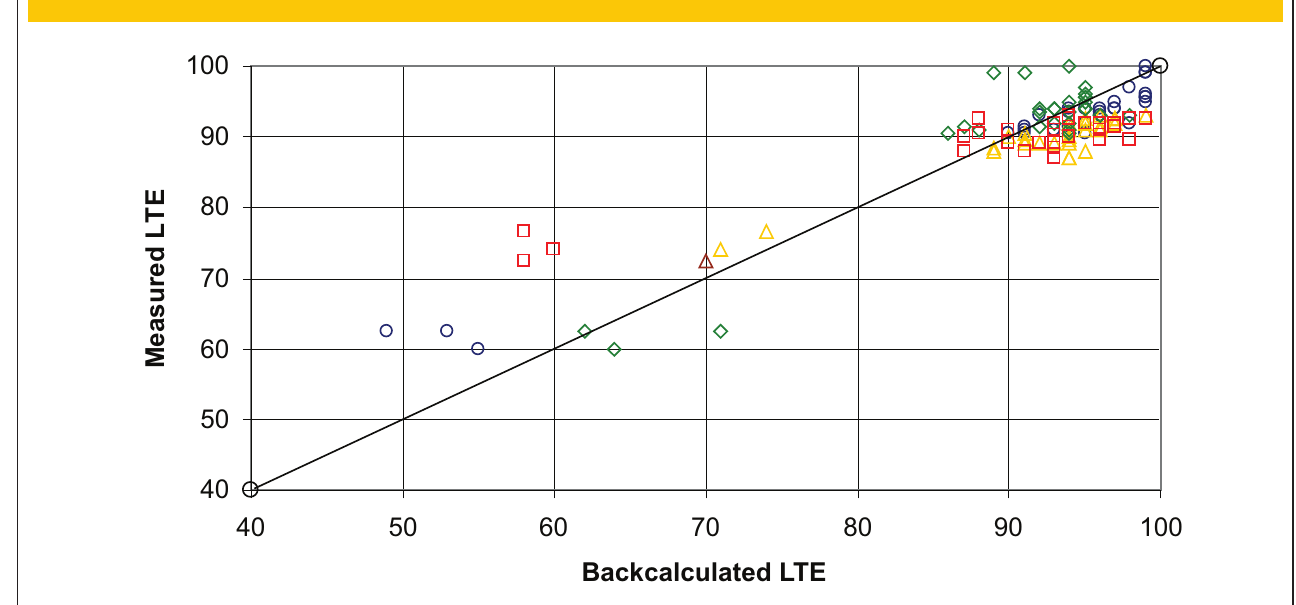
Figure 7 – Comparison of backcalculated and measured LTE values for doweled joints